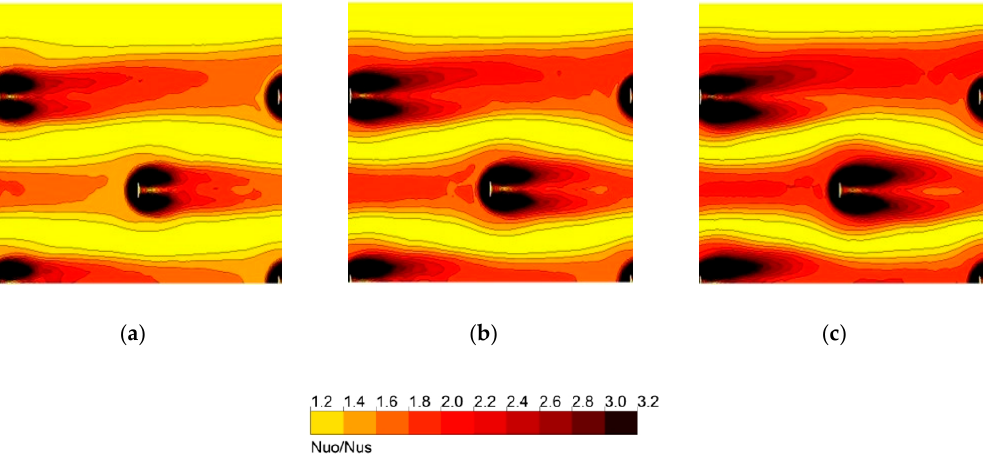
Figure 14. Nusselt distributions on the heated surface between fifth and seventh ribs for different e/W. ( a ) e/W = 0.067; ( b ) e/W = 0.10; ( c ) e/W = 0.133.